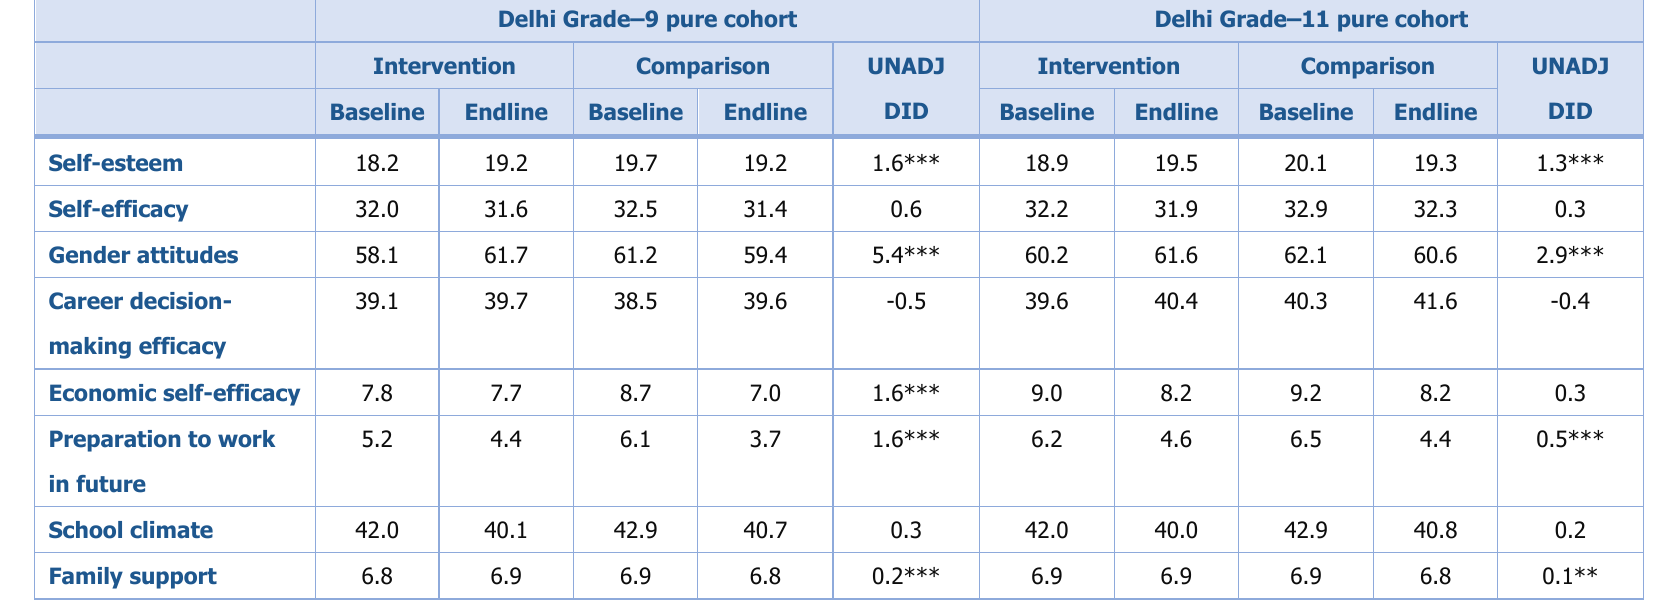
Table 3. Mean Scores of Empowerment and Employability Outcome Variables Over Time Across Comparison and Intervention Schools and DID in